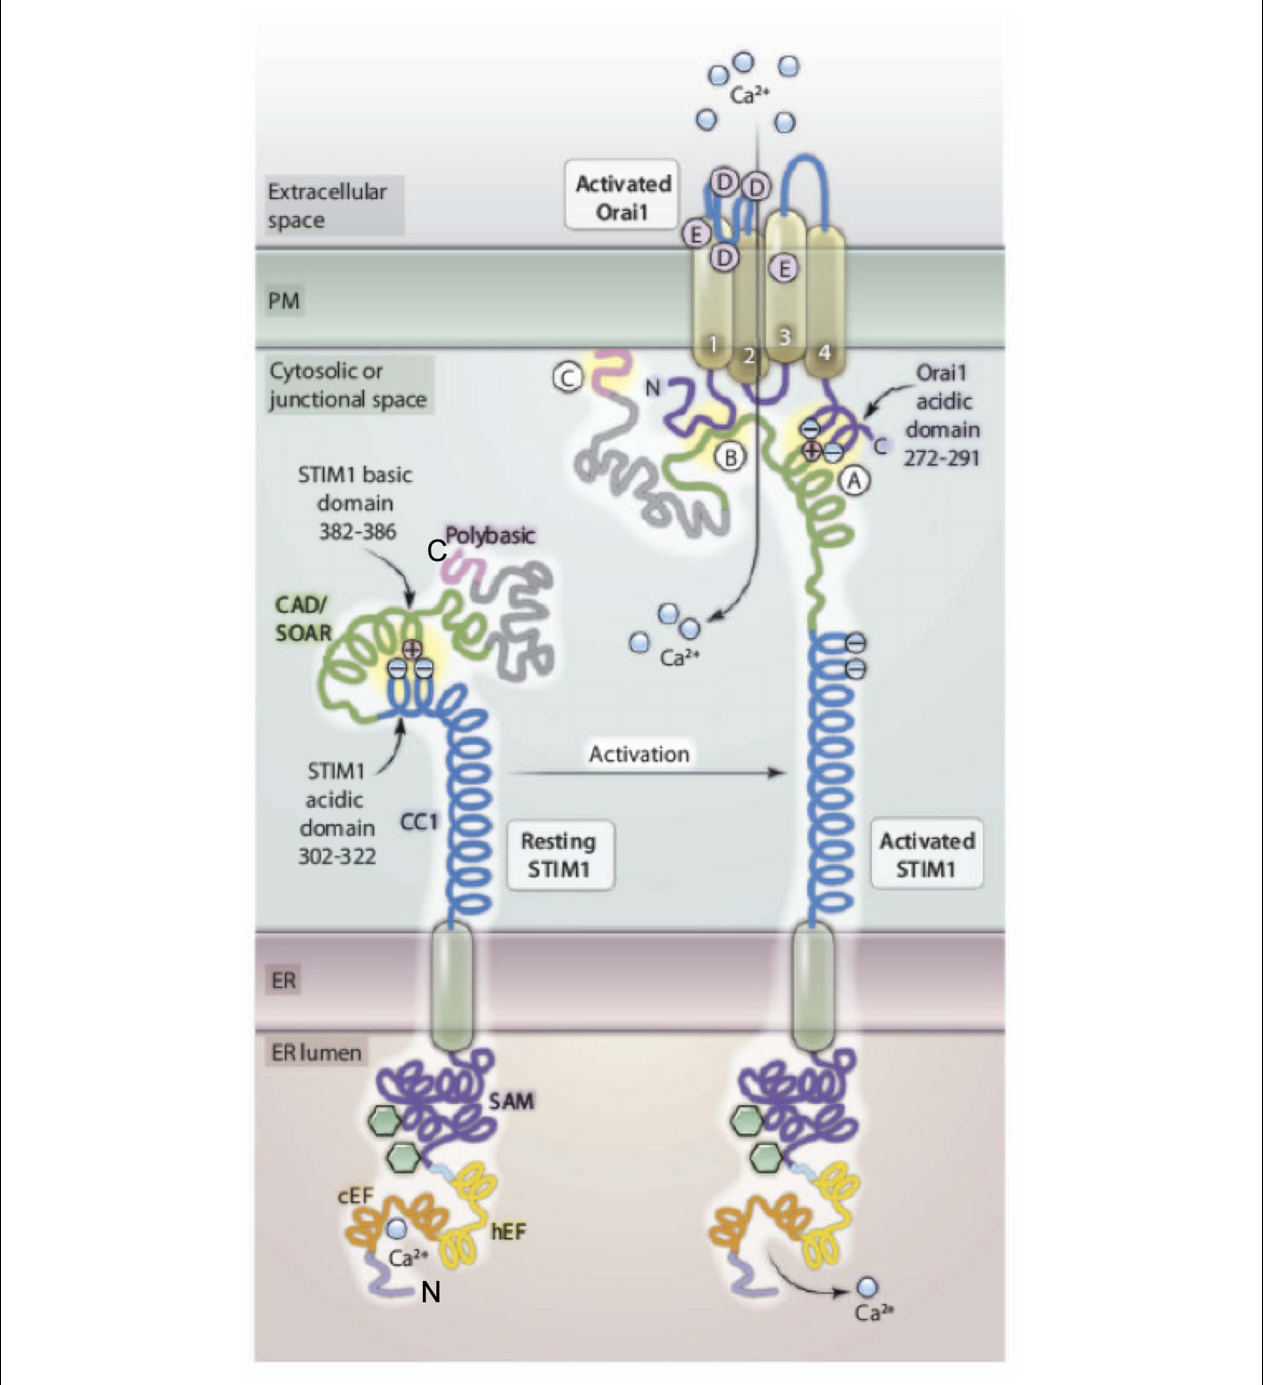
electrostatic interaction between CC1 and CAD are broken, and the positively charged sequence in the CAD domain is free to interact with the acidic domain within the C-terminal domain of Orai1 (A) to activate the CRAC channel formed by Orai1. STIM1 also interacts with the N-terminus of Orai1 (B), and the C-terminal polybasic sequence of STIM1 associates with PIPs at the plasma membrane (C). STIM1 and Orai1 monomers are depicted for simplicity; interactions involve oligomers of these proteins in a multimeric complex. Modified fromWang et al.